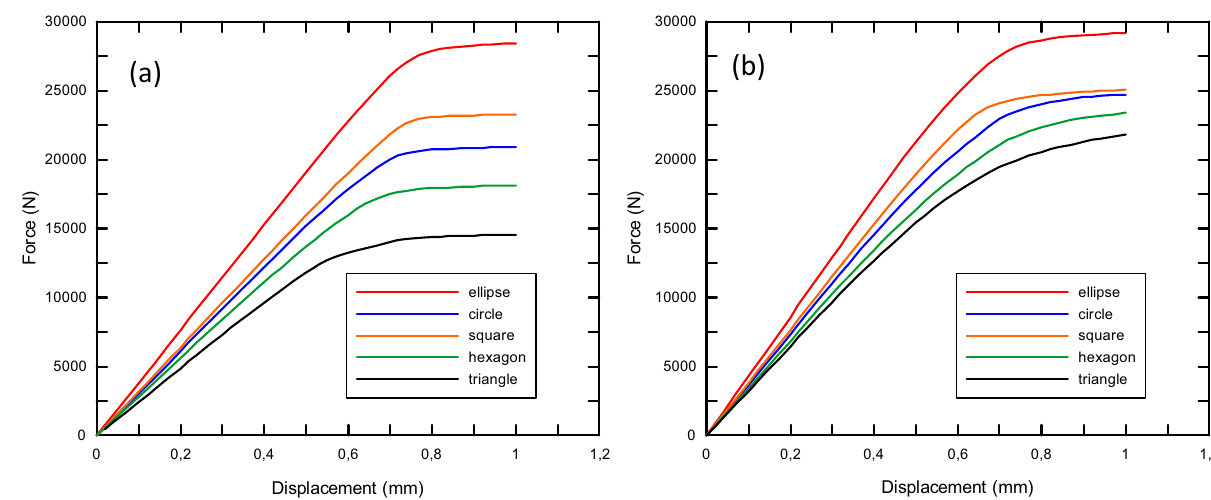
Figure 4: The force – displacement curves of the aluminium sheet metal ( a ) linear arrangements and ( b ) staggered arrangements.